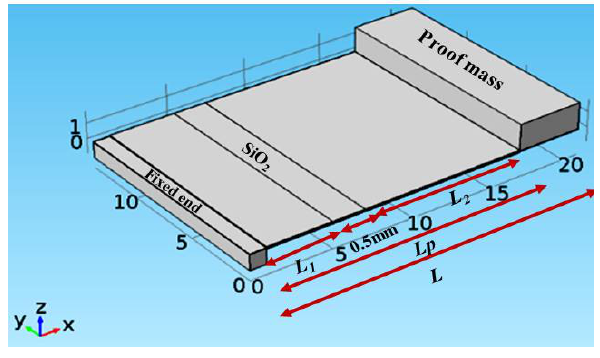
Figure 4. 3D representation of the proposed structure with n = 2.